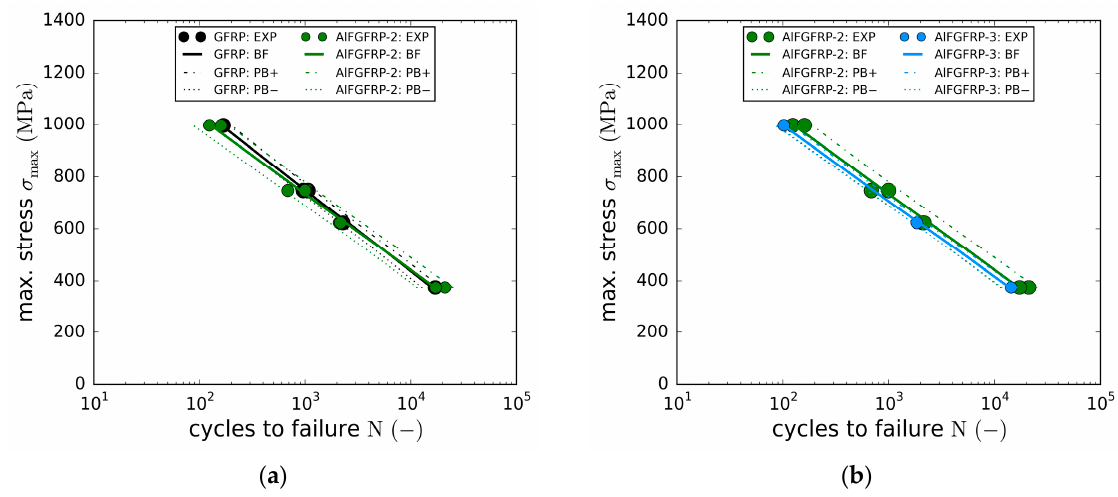
Figure 13. SN curves with regression and prediction bands: ( a ) comparison of the AlFGFRP contain- ing work-hardened aluminum (AlFGFRP-2) with the GFRP reference laminate; ( b ) SN curve com- parison revealing the impact of the wire condition, work-hardened (AlFGFRP-2) and soft-annealed (AlFGFRP-3).